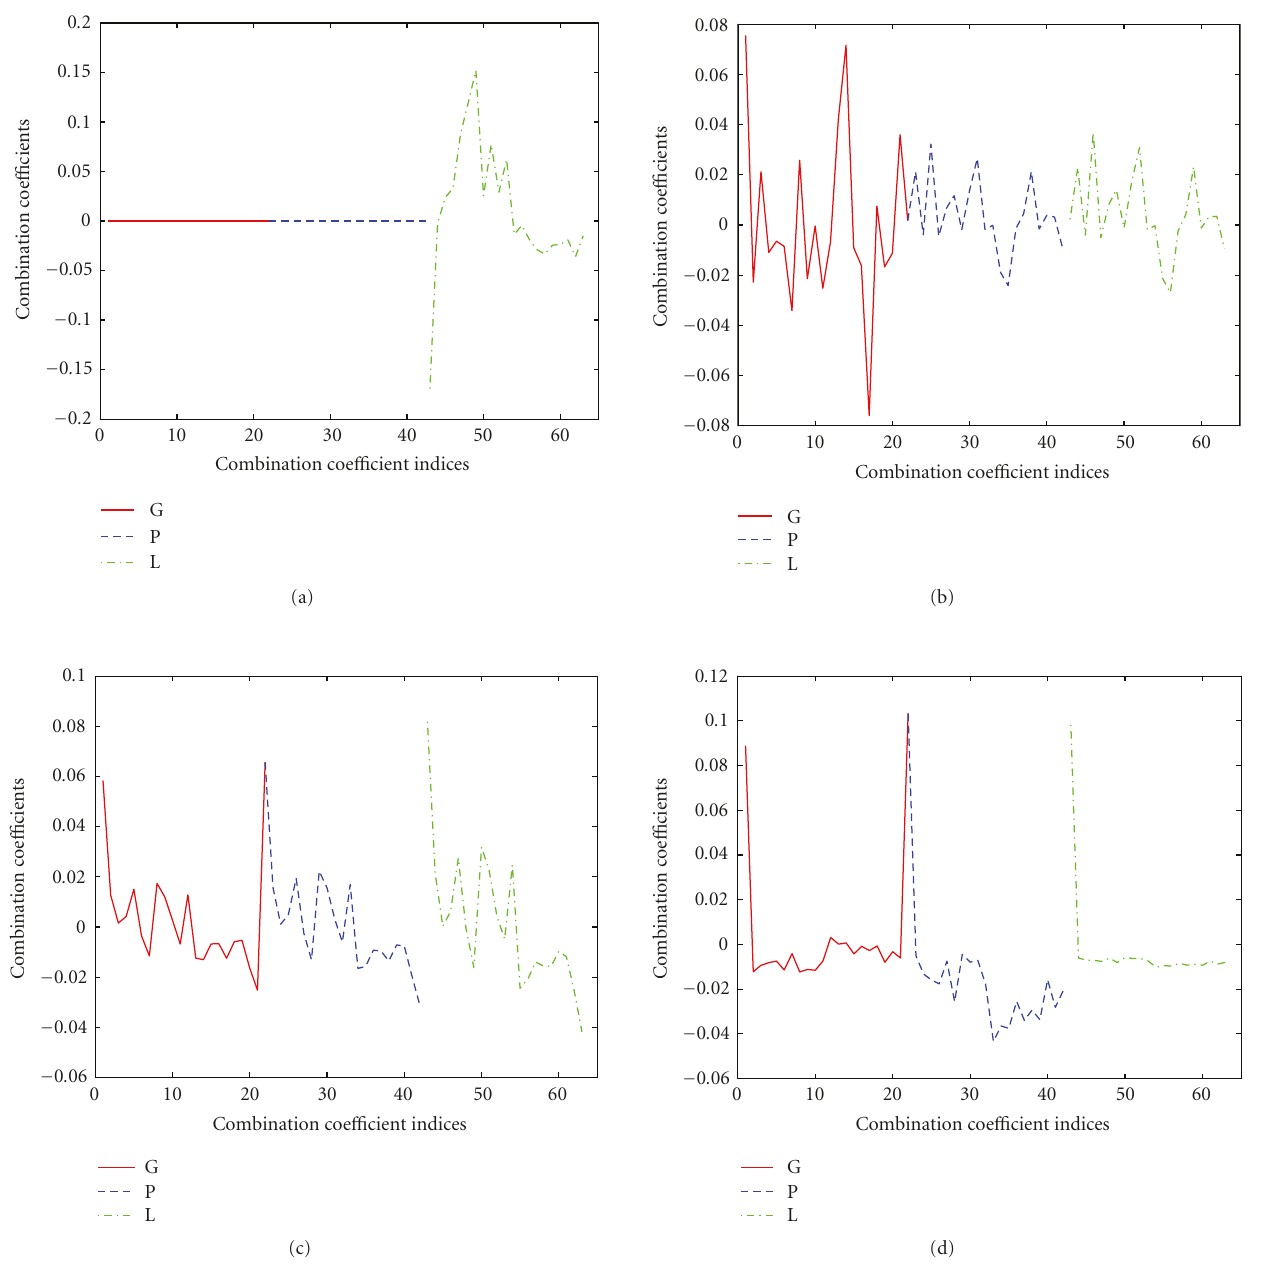
Figure 3: The combination coe ffi cients corresponding to four datasets. (a) BCW; (b) pima; (c) liver; (d) ionosphere.